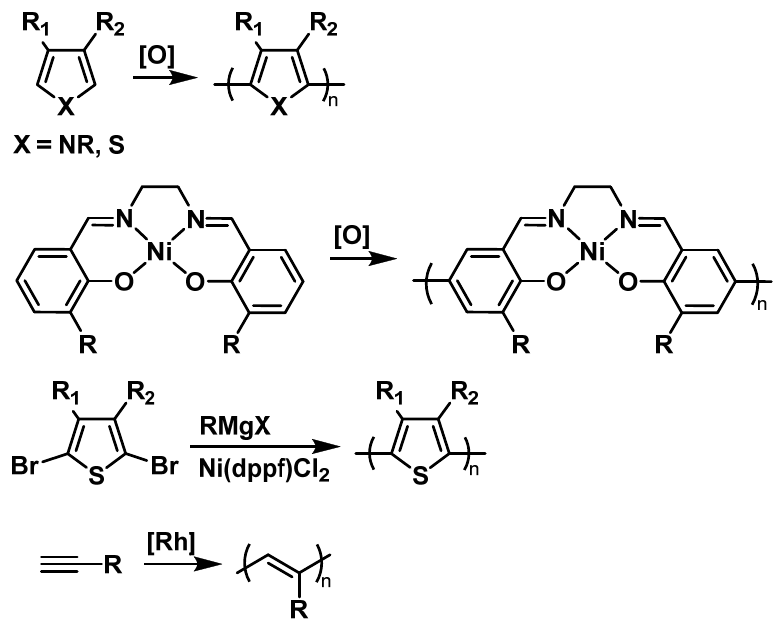
Figure 2. Typical polymerization schemes for the preparation of functional conductive